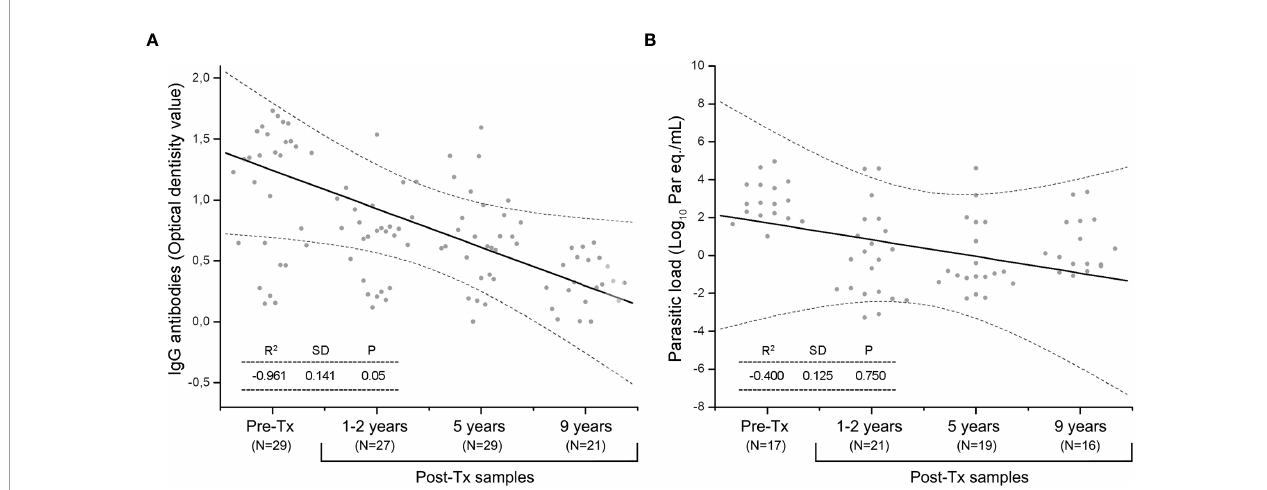
FIGURE 3 | The Spearman ’ s rank correlation coef fi cient during Post-Tx follow-up in patients of the Chichiriviche de la Costa oral Chagas disease outbreak. (A) IgG serology; (B) SatDNA-qPCR parasitic loads. Dotted lines indicate the 95% con fi dence interval. P value <0.05 indicates the signi fi cance of the correlation between the